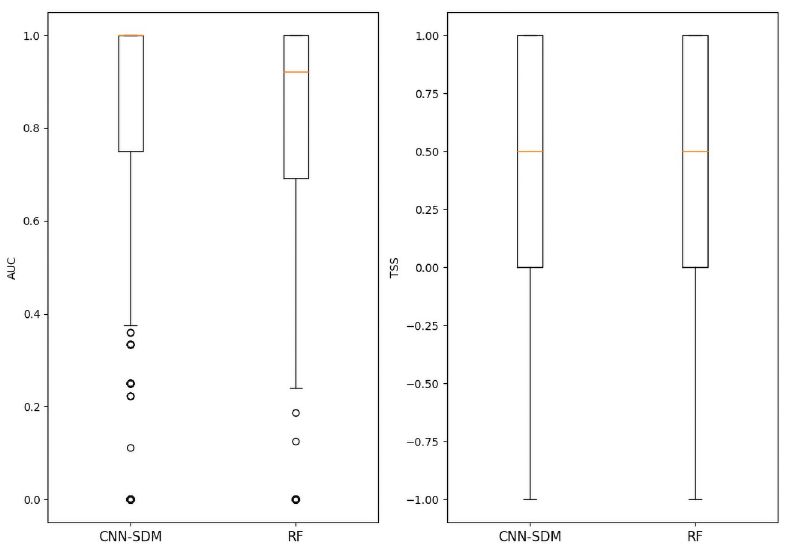
Fig 8. AUC per species. Boxplots of AUC and TSS of CNN-SDM, and RF for all species.